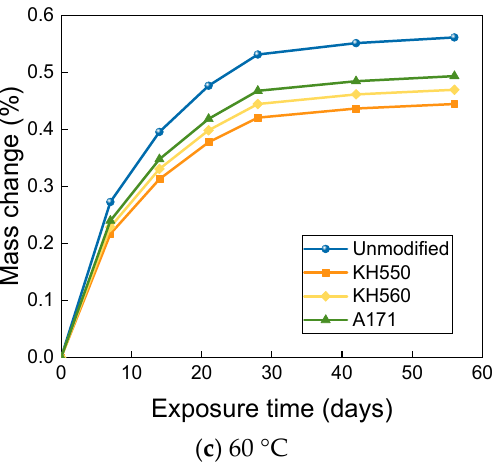
Figure 14. Mass change in a 10% NaCl high-concentration seawater environment.